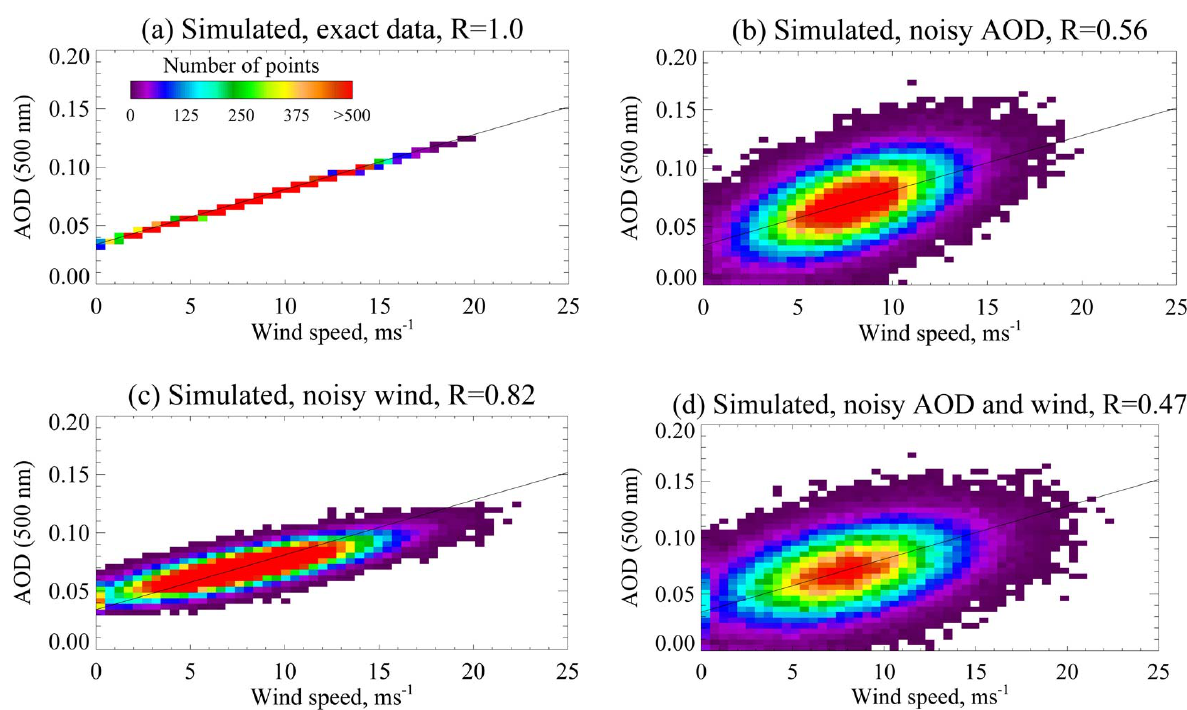
Fig. 7. Scatter density histogram between simulated noise-free wind speed and noise-free AOD (a) , noisy AOD and noise-free wind speed (b) , noisy wind speed and noise-free AOD (c) and noisy wind speeds and noisy AOD at 500nm (d) . Points were generated assuming the steady- state relationship in Table 3, τ a (500nm)=0.0047 × w +0.034 (shown in black), and then adding Gaussian noise of amplitude 2ms − 1 to the winds and 0.02 to the